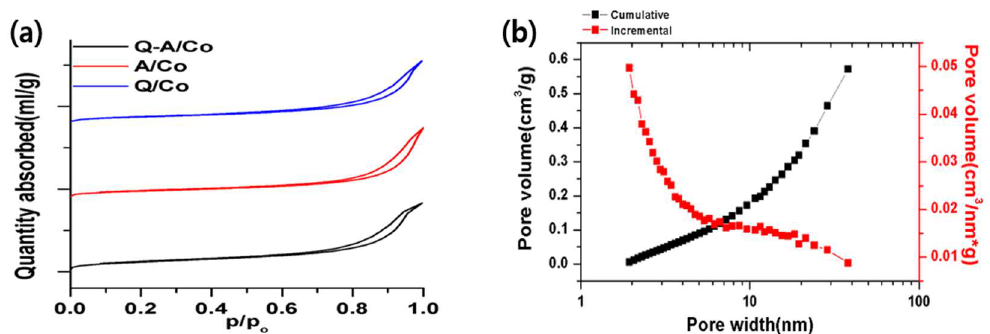
Figure 3. ( a ) SEM image of the Q-A / Co catalyst. ( b – e ) EDS mapping of the synthesized Q-A / Co catalyst: ( b ) carbon, ( c ) cobalt, ( d ) nitrogen, ( e ) oxygen.